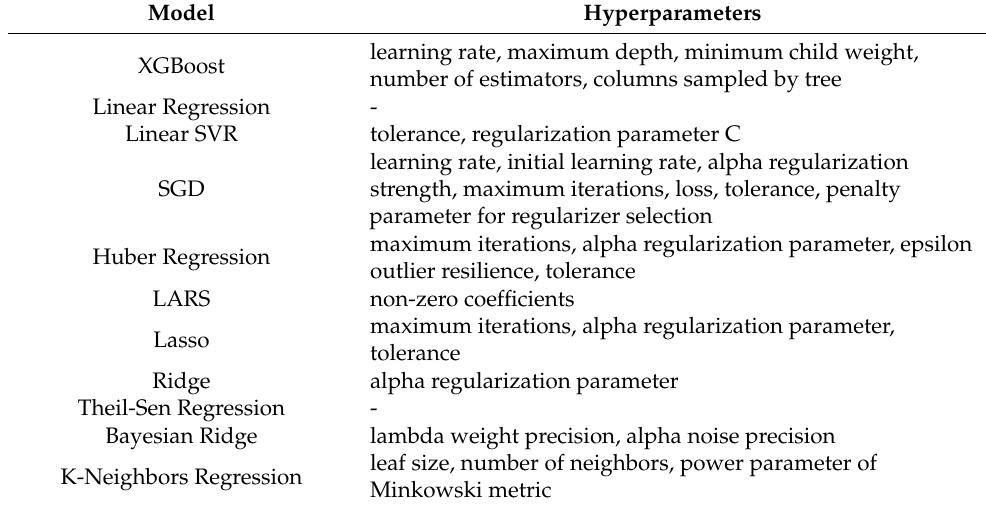
Table 1. Base estimators and